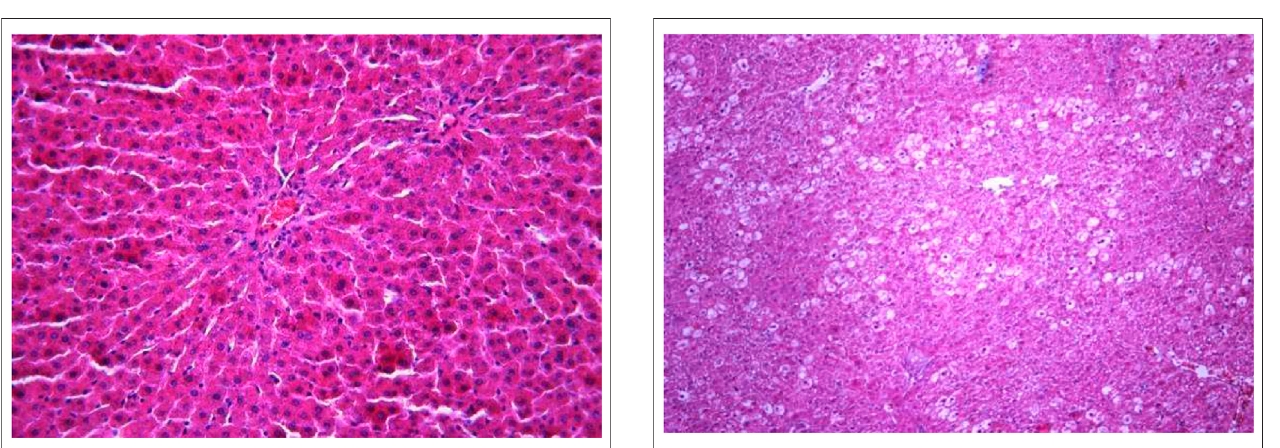
FIGURE 4 | Liver tissue. Positive control group. The structure of hepatic lobule is broken; signs of hydropic and vacuolar dystrophy of hepatocytes. Stain: hemotoxin and eosin. Magni fi cation × 100.